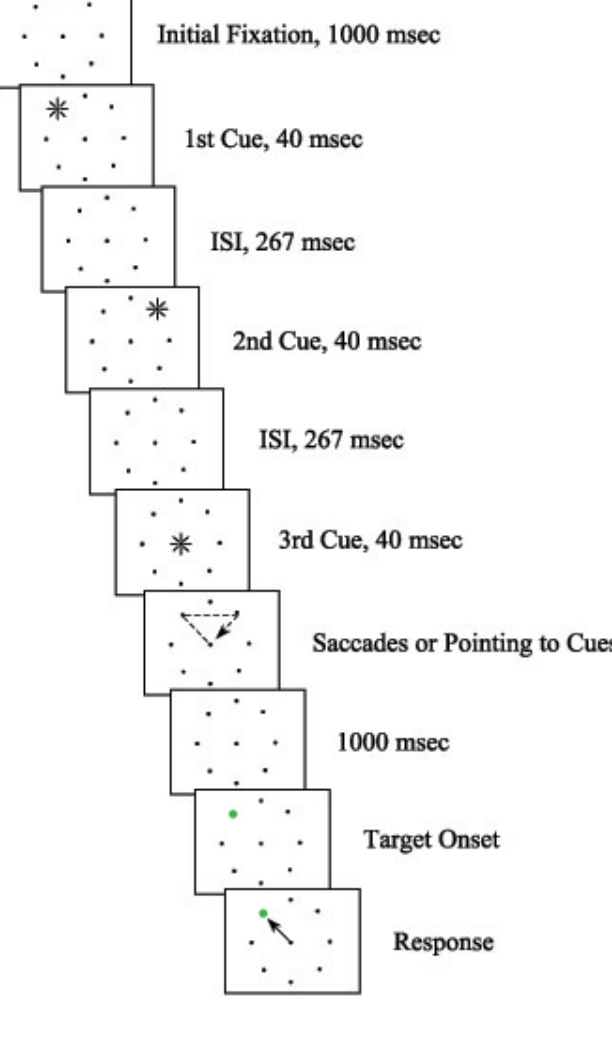
FIGURE 2. Sequence of events during each trial in the Respond condition. For the Ignore condition, the sequence was identical with the exception that no responses to the cues were